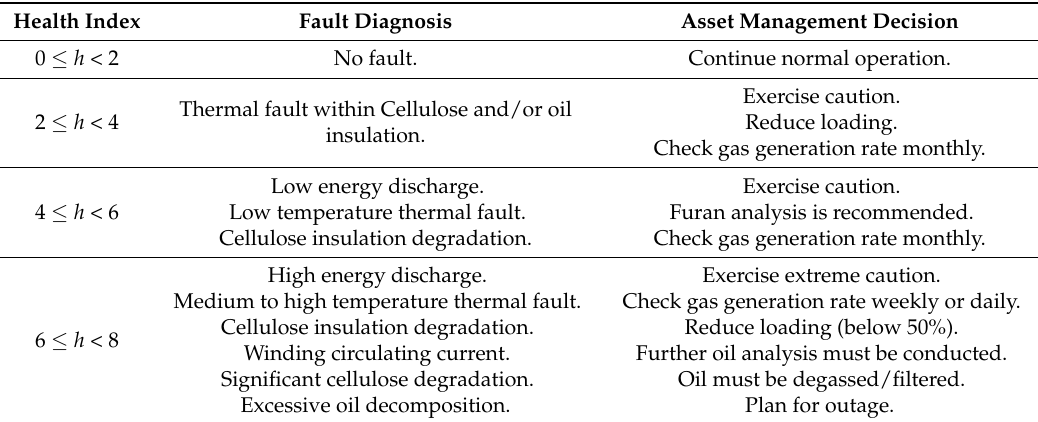
Table 3. Model output health index and corresponding proposed asset management